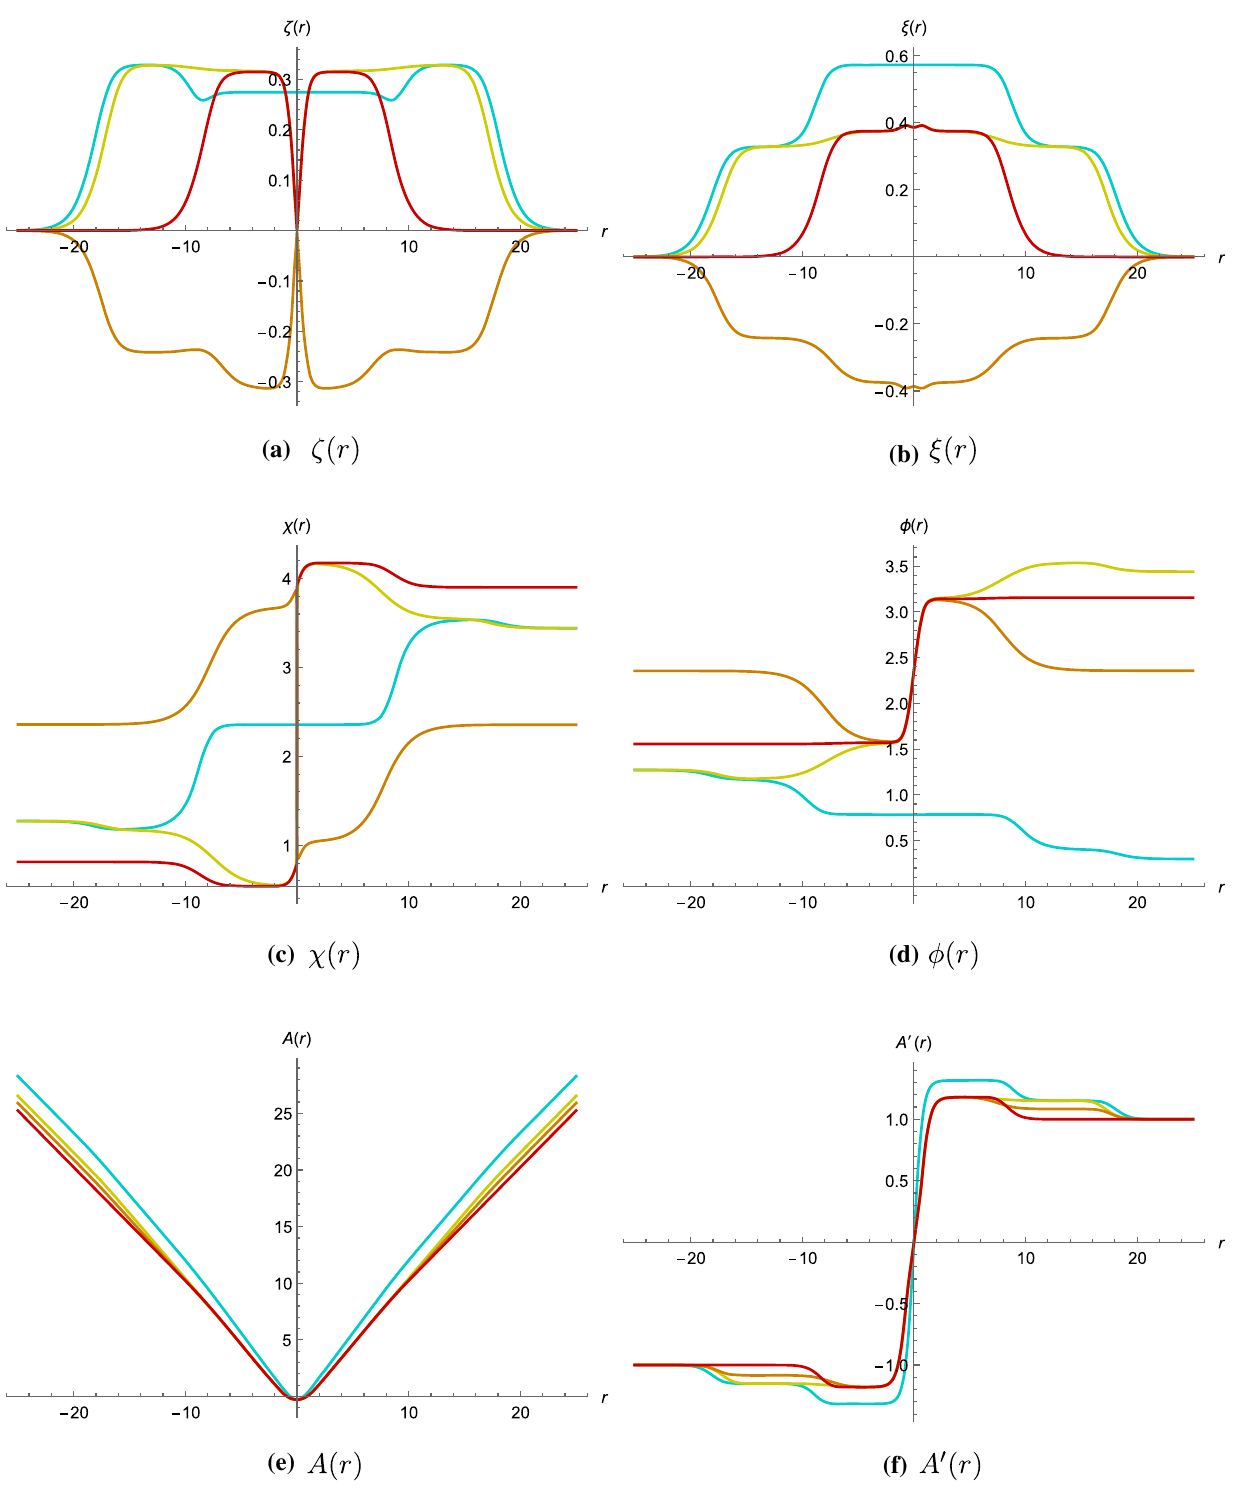
Fig. 16 Profiles of scalar fields (ζ,ξ,χ,φ) and the warped factor A as functions of the radial coordinate r for U ( 3 )/ U ( 3 ) Janus together with G 2 / G 2 and G 2 / G 2 solutions that flow to U ( 3 ) and SU ( 3 ) critical points with ω = π